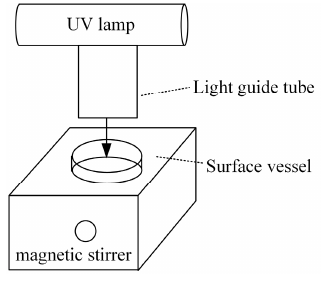
Figure 1. Experimental setup.